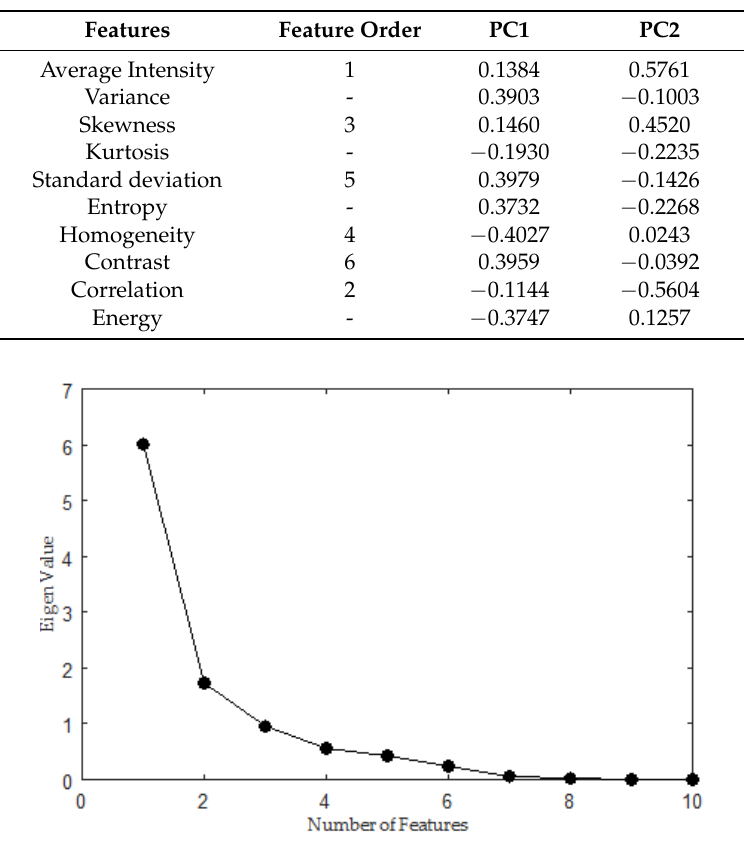
Table 3. Eigen vectors of PC1 and PC2.